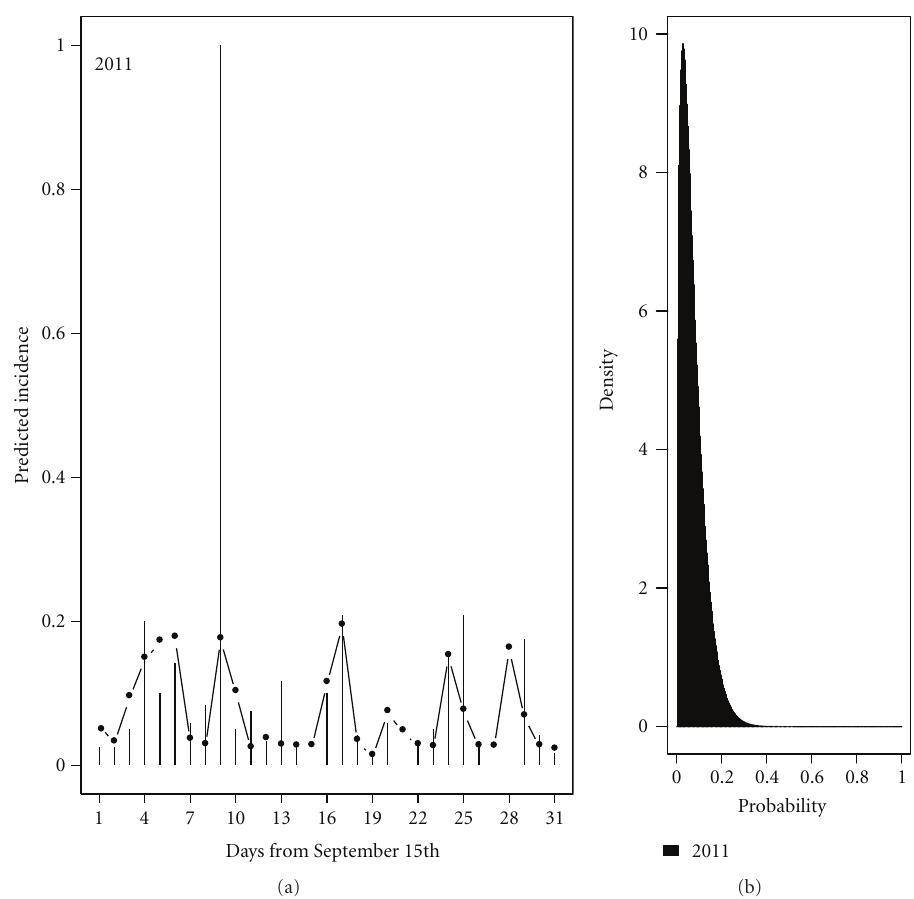
Figure 4: Validated model of spores incidence using climate variation in Passo Fundo, Brazil. The vertical lines represent the observed values and the continuous line the predicted values (a). Estimated density for the beta probability distribution function (b). The validation period was from September 15 to October 15,